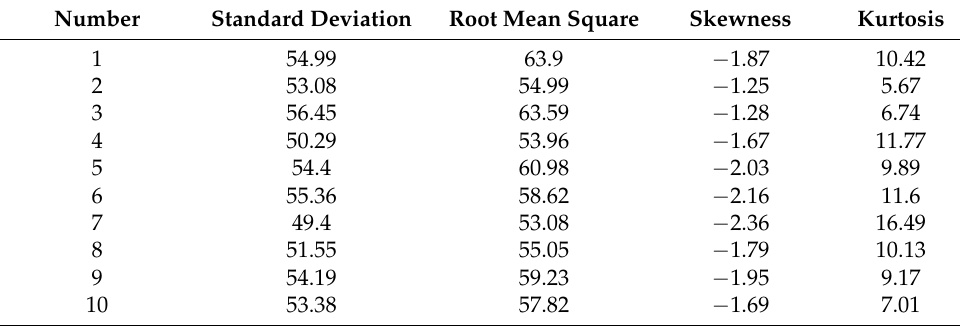
Figure 4. Collected 10 groups of vibration signals (before filtering). Table 3. Stability table of collected 10 groups of vibration